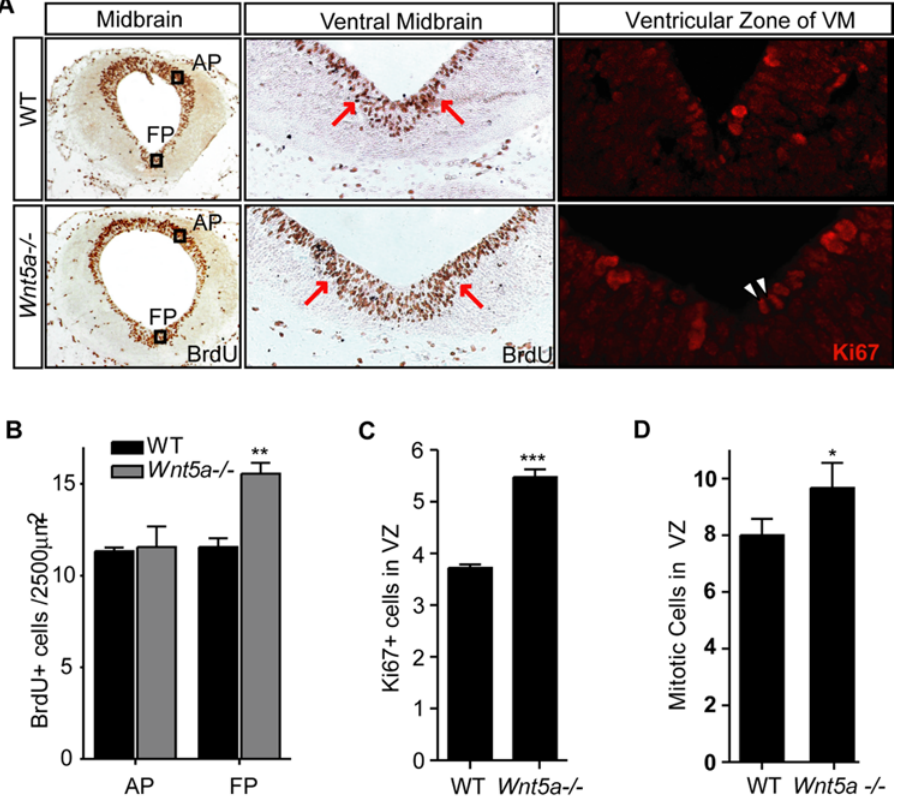
Figure 4. Increased proliferation and accumulation of progenitor cells in Wnt5a 2 / 2 mice. (A). Representative coronal sections at the level of the midbrain of 2 hr BrdU-pulsed WT and Wnt5a 2 / 2 embryos at E11.5 immunostained for BrdU or Ki67, markers of cells in mitosis. The black squares in (A) depict the area within the alar plate (AP) and floor plate (FP) used for the quantification of BrdU + cells in (B) (Squares in (A) are not drawn to scale). Note the accumulation of BrdU + cells in the Wnt5a 2 / 2 VM in the adjacent magnified box. Increased Ki67 staining and mitotic figures (arrowheads) in the ventricular zone. (B) The density of BrdU + proliferating cells was significantly increased within the FP, but no significant change was found within the AP of Wnt5a 2 / 2 embryos compared to their wt littermates (C) The number of Ki67 + cells was significantly increased at E12.5 (paired t-test, p=0.003, N=3). (D) Mitotic nuclei (arrowheads in (A)) were counted in the midline domain to asses the number of cells in M-phase, and this was also found to be significantly increased in the Wnt5a 2 / 2 mutant (paired t-test, p=0.037,